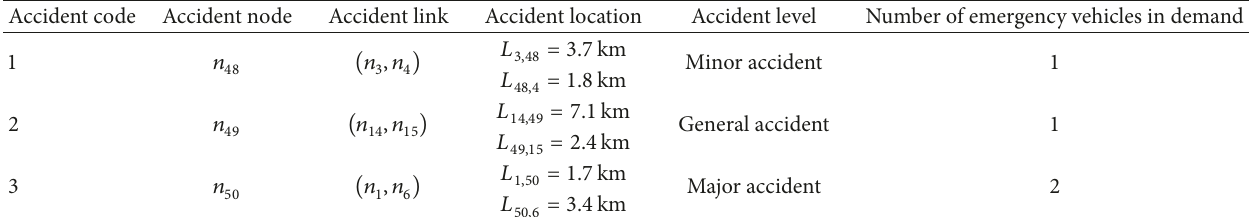
Table 1: Accident